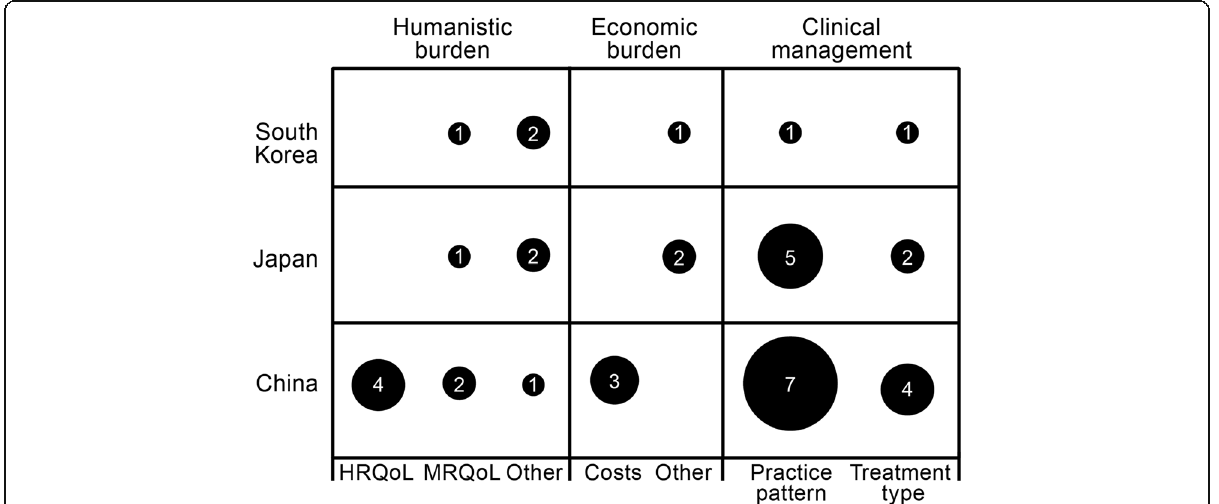
Fig. 3 Number of studies reporting humanistic burden, economic burden, and clinical management of migraine. The size of the circle and numeral denotes the number of publications reporting each outcome; publications could be counted more than once. For burden, health-related quality of life (HRQoL) includes general health instruments, migraine-related quality of life (MRQoL) includes the Migraine Disability Assessment Questionnaire and Headache Impact Test-6, and Other includes various measures including bedrest, aspects of daily living, and school absence. Studies reporting prevalence only are not reported